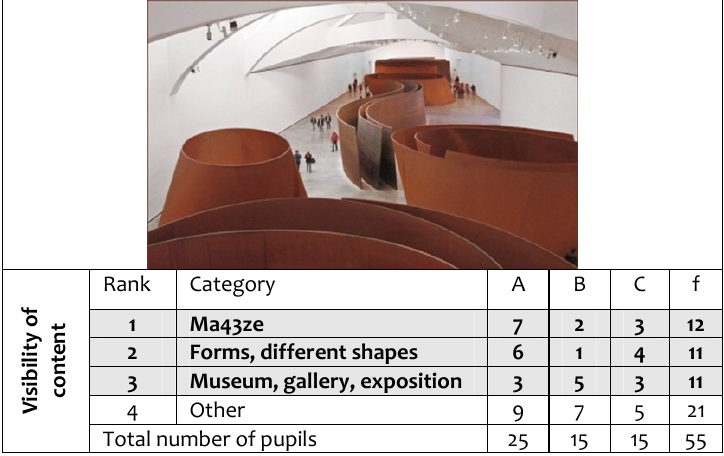
Table 10: Ranking order of categories of answers regarding the visibility of the content of the fourth example (Richard Serra: Snake,